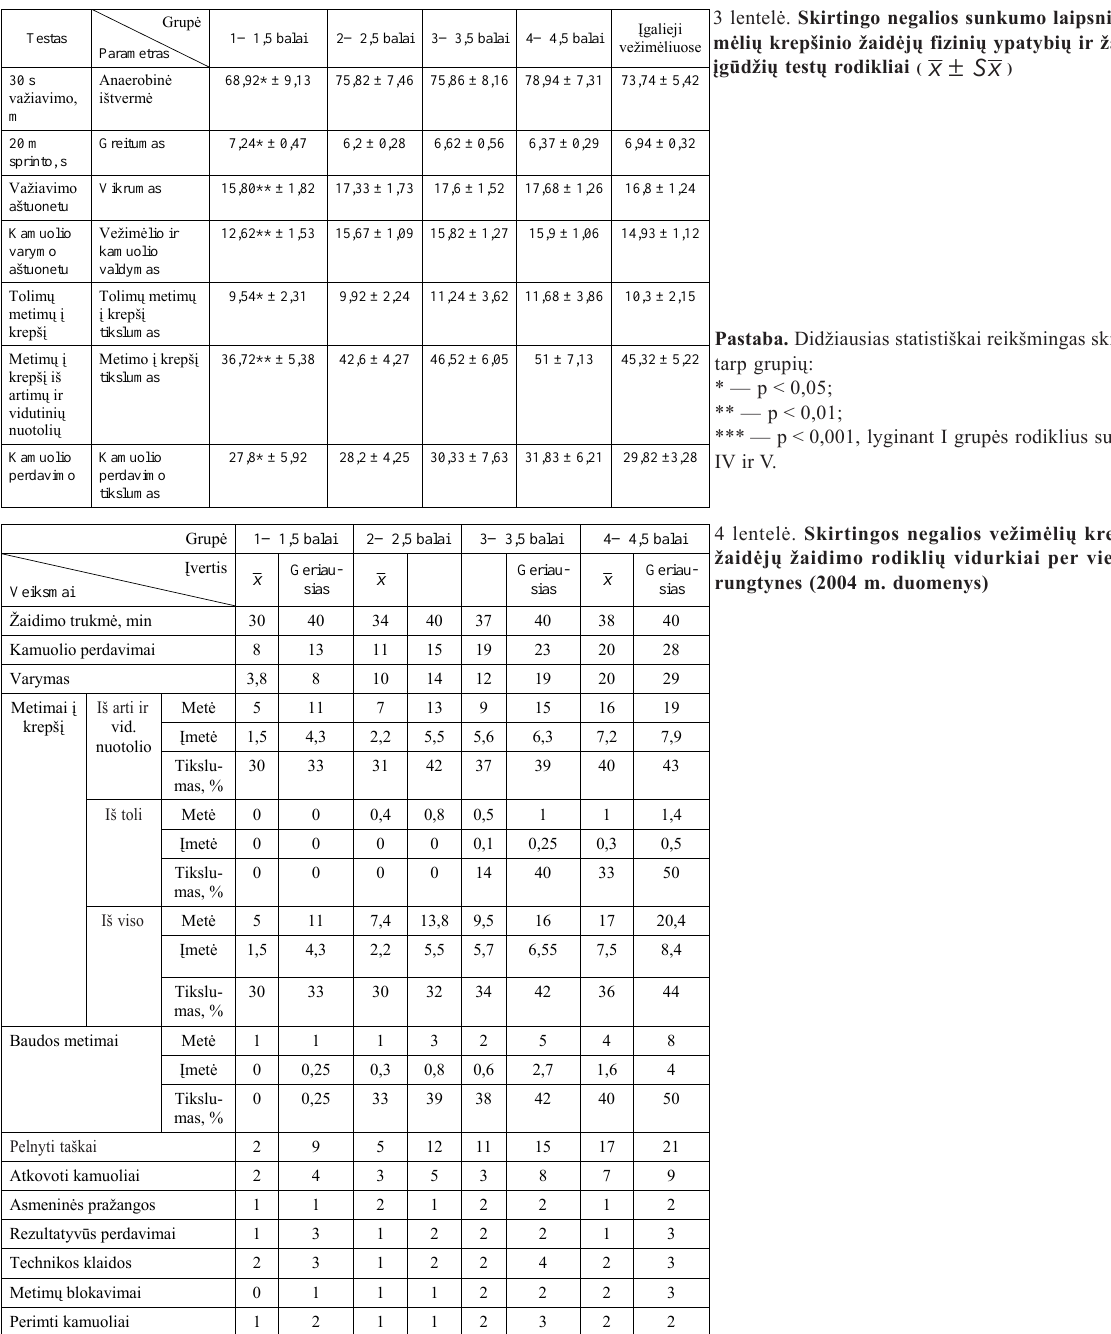
3—3,5), sutinka, kad į galieji dalyvaut ų vežim ė li ų krepšinio varžybose (atitinkamai 12, 14 ir 8, 6%). Dauguma vežim ė li ų krepšinio žaid ė j ų paten- kinti savo klasifikacijos klase (žr. 2 pav.). Dau- giausia ja patenkinti 1—1,5 (92%) ir 4—4,5 (94%) bal ų žaid ė jai. Nepatenkint ų daugiausia tarp 3—3,5 bal ų žaid ė j ų (27%).